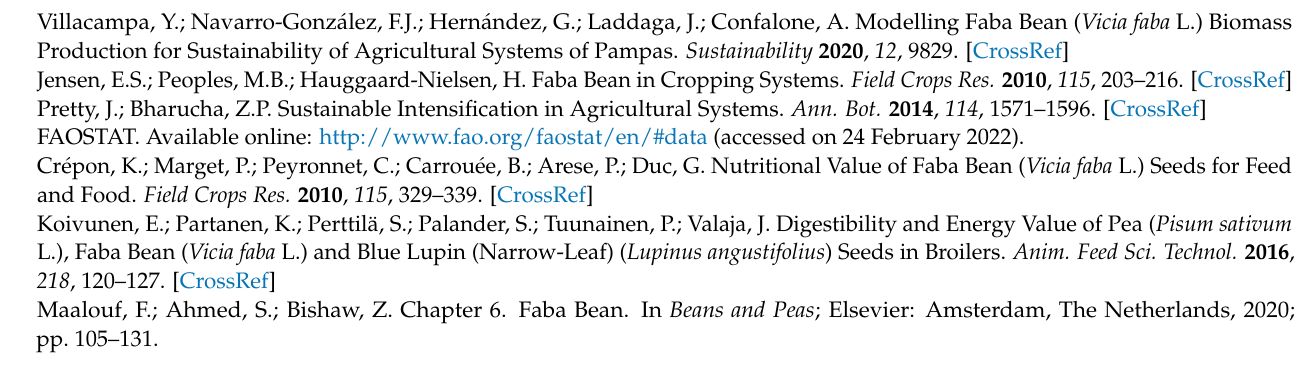
GWAS model; Table S2: Multi-trait genome-wide association study (MT-GWAS) results for grain yield and yield components. Underlined p -values are the significant p -values while underlined SNPs are the SNPs that were detected in multiple